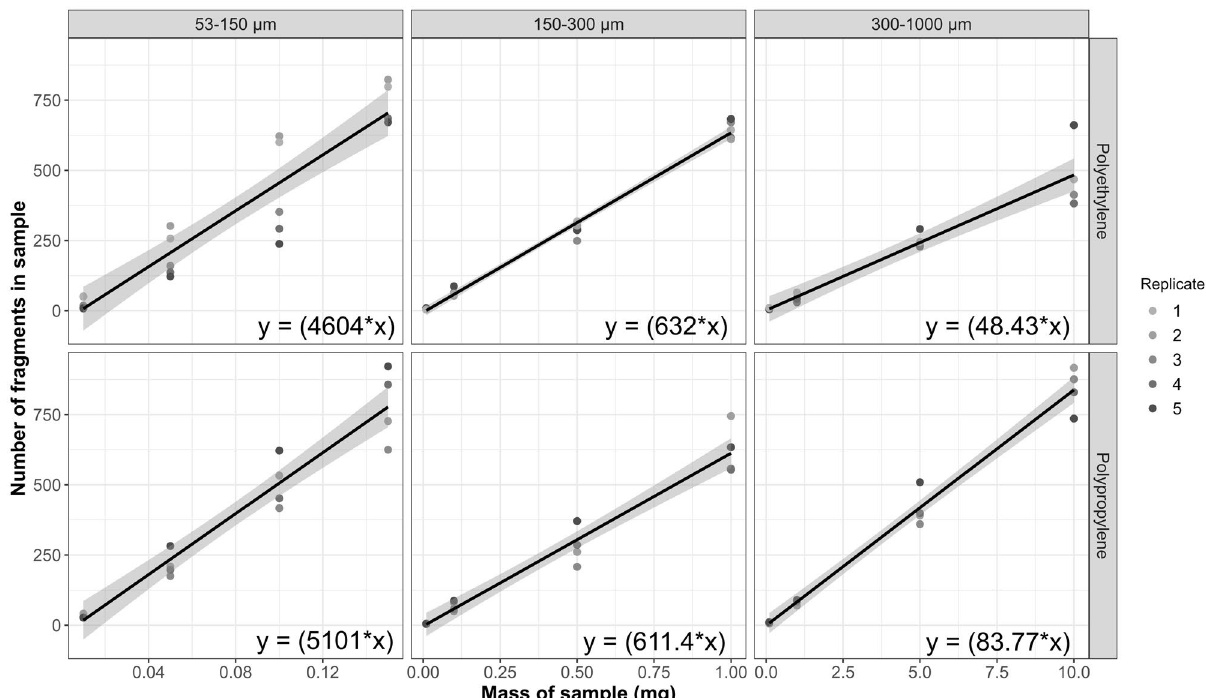
Figure 4. Linear regressions for each size class and polymer type. The origin for each regression was set through 0.0. Equations resulting from each regression (displayed in their respective panel) were used to calculate the amount of microplastics to add to an experimental solution for each target concentration (y = target number of microplastic fragments, x = mass of microplastics to be weighed out in mg). All regressions confirmed a significant linear relationship between the number of fragments and the mass of the sample in mg ( P < 0.001, Supplementary Table repeated a total of four times for each sample. The resulting fragments were transferred to a stack of dry metal sieves (1000, 300, 150 and 53 μm; Hogentogler & Co.). The top sieve was sealed with parafilm, and the stack was shaken by hand for 5 min. The material on each sieve was rinsed into individual beakers with 0.2 μm-filtered deionized water (F-DIw) and vacuum filtered onto 20 μm polycarbonate filters. This process resulted in three size fractions: (i) 53–150 μm; (ii) 150–300 μm; (iii) 300–1000 μm. The microfragments on each filter were then poured into a respective glass beaker containing 100 mL of 0.1% (v/v) Tween-80/F-DIw solution. Using a stir plate and stir bar each sample was mixed at 600 rpm for ten minutes to suspend and separate smaller particles that may have been contaminating the size fraction. Each beaker was then poured back through its respective sieve and rinsed with F-DIw for five minutes. Microfragments collected on the sieve were vacuum filtered onto a 20 μm polycarbonate filter. The filter was transferred to an aluminum dish and enclosed inside a glass petri dish to dry for 24 h. While it was not tested, it may be possible to skip the initial dry-sieving step, and instead, start with the washing step. This could increase sample yield and save time. Microfragment analysis. To assess the consistency of the production technique, the entire production process was repeated four times for each polymer type (polyethylene and polypropylene). Subsamples of each replicate were spread onto individual glass slides (the mass of each subsample was relative to the size class). Microfragments were quantified by hand under a stereo microscope (Zeiss Stemi 2000-C) and photographed (Canon EOS Rebel T3i). A linear regression (number of fragments ~ subsample mass) was used to calculate a dosing equation for each polymer type and size class. Microfragment size was determined by measuring the longest axis (ImageJ, FIJI) of 100 fragments from each production replicate. Sample images were selected at random, and fragments were measured from left to right until the limit of 100 was reached. To confirm polymer integrity, analysis by micro-FTIR (Spotlight 200i micro-FTIR) was performed on subsamples of each polymer type. Furthermore, spectral comparisons of microfragments before and after the Tween-80 washing step were conducted to confirm a lack of residue on the produced fragments. Novel ice cap dosing protocol. dome of F-DIw was then pipetted onto the microfragments releasing them into the dome of water. Forceps were used to release any remaining microfragments from the cover glass into the surface of the dome. Microfragments that are not released into the surface of the dome may be left behind during the subsequent transfer to the vial cap. The cover glass was then transferred to a − 80 °C freezer for thirty minutes. Once frozen, the cover glass